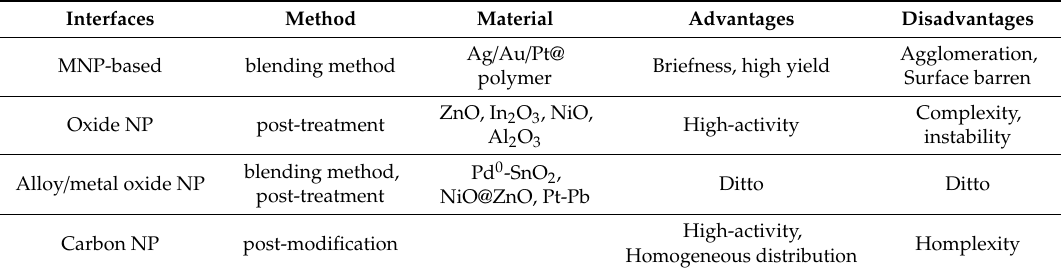
Table 1. Summary on the electrospinning methods for fabricating various NP-based materials interfaces.